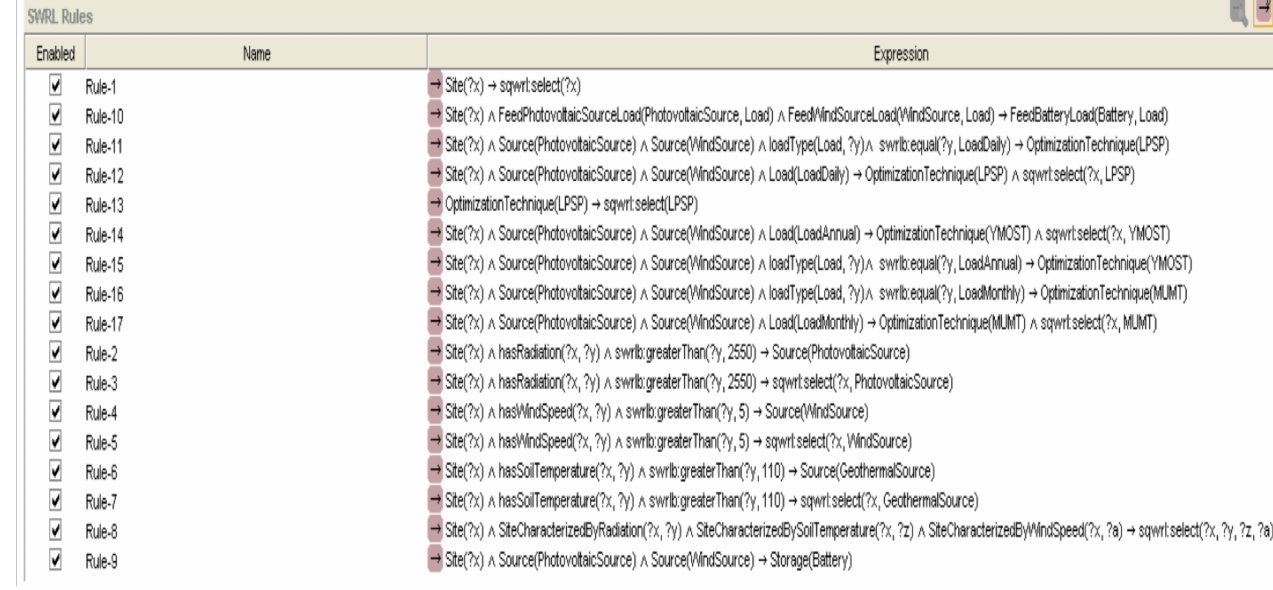
Figure 4. Rules of inference in Prot é g é -OWL.